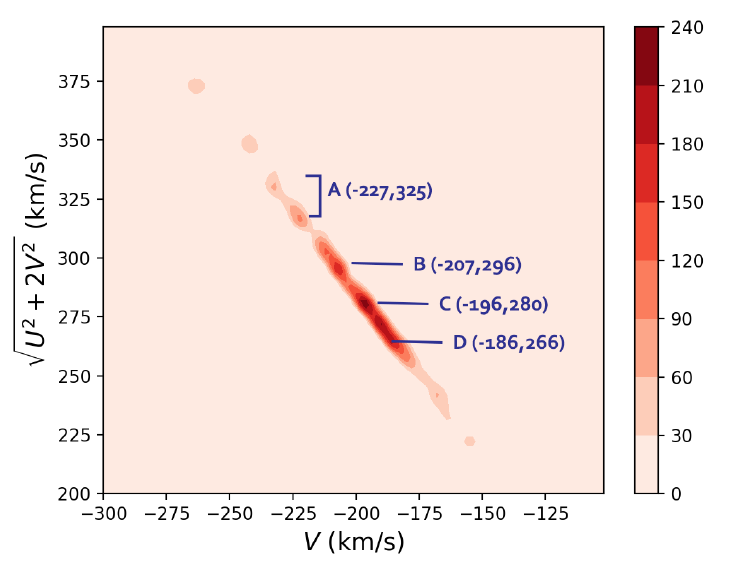
Fig. 2. Four groupings found after cleaning the data using Monte Carlo simulation.